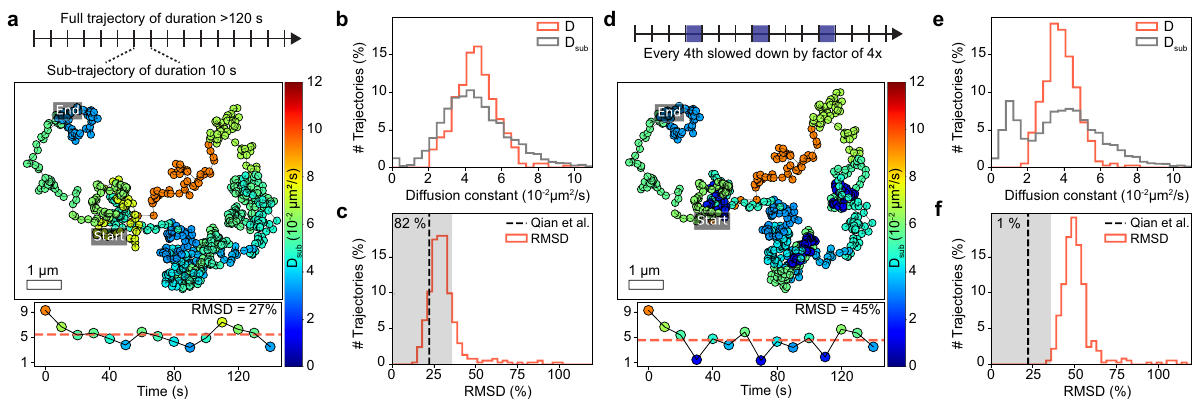
Fig. 3 Subtrajectory analysis of TH origami diffusion on SLB. Trajectories exceeding 120 s in duration were divided into sub-trajectories of duration 10 s and analyzed by the same MSD fi tting procedure. a In the exemplary trajectory each localization is color-coded according to the obtained diffusion constant D D D (red dashed) as obtained from sub of the corresponding subtrajectory. Time dependent scatter of sub (see colorbar in a ) around the diffusion constant analysis of the full trajectory. b Total distribution of D and the corresponding subtrajectory diffusion constants D sub . c Root-mean-square deviation (RMSD) distribution of D to D of all trajectories exceeding 120 s (red). RMSD was normalized to D and should hence be close to the theoretical limit for the sub relative standard deviation of D sub (black dashed) if the TH origami are subject to a time-invariant Brownian motion (Supplementary Note 3). Gray area indicates deviation of <60% to the theoretical limit. ( d , e , f ) same as ( a , b , c ) but with sub-trajectories computationally slowed down as indicated in ( d